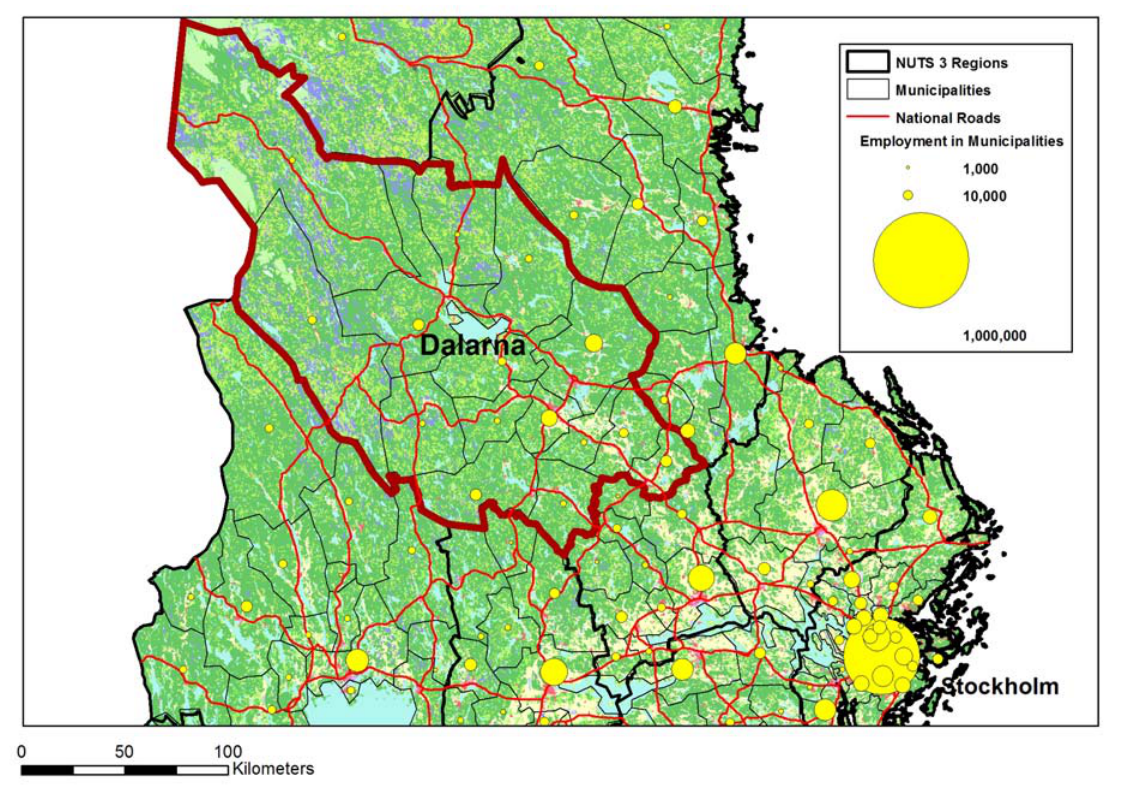
Figure 1. The location of